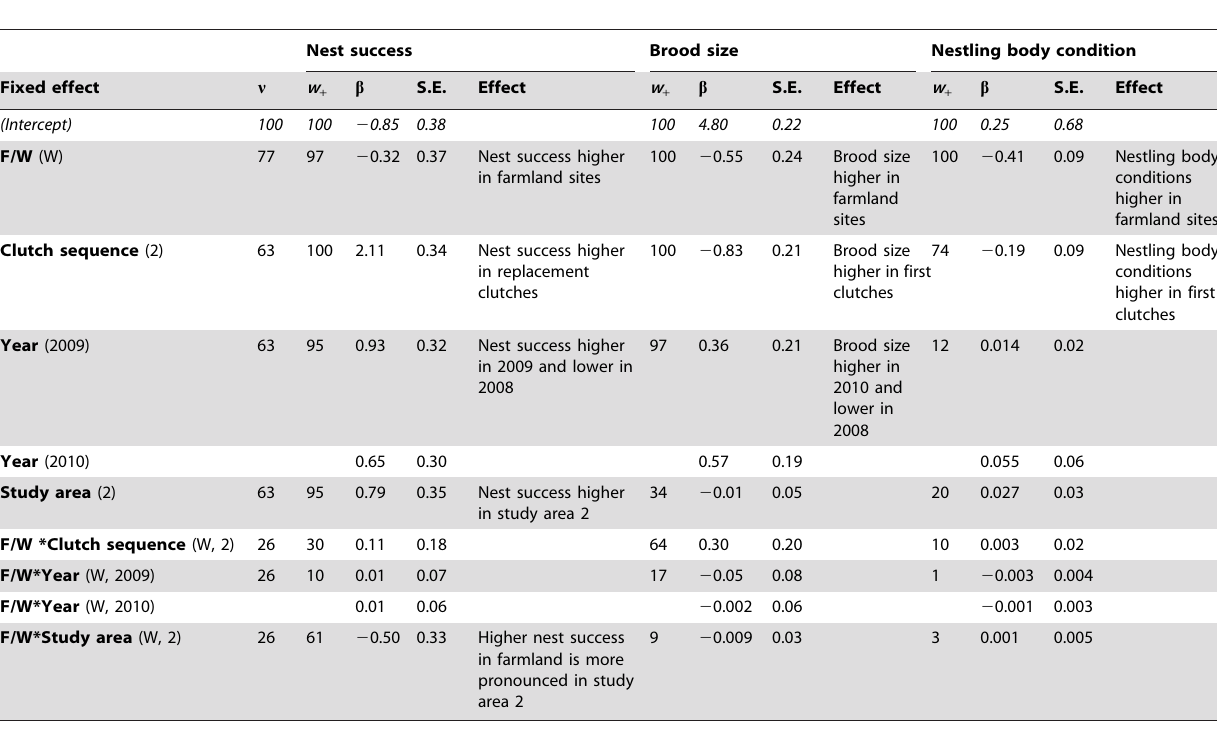
Table 3. Results of the AIC c -based multimodel inference procedure examining the variations in season-long reproductive performance relative to the independent variables.